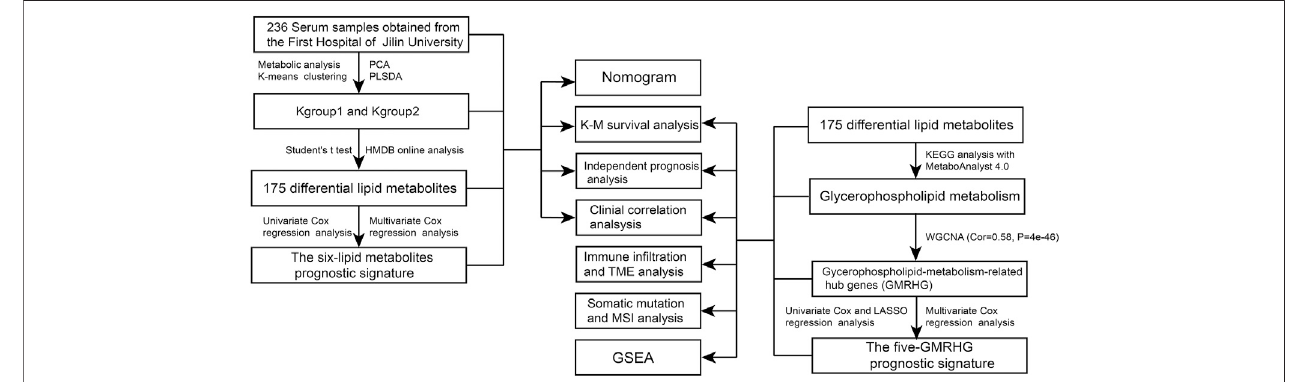
FIGURE 1 | The fl ow chart of the study.